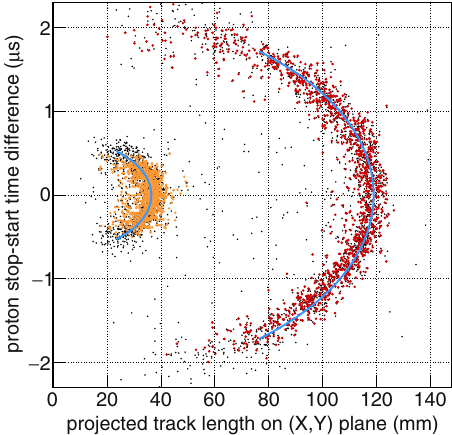
Fig. 4 Drift velocity estimate from tracks fi ts. The plot shows the distribution of the drift time difference between proton stop and start points versus the projected length of the signal on the ( X , Y ) pad plane. The colour points are events selected for the drift velocity estimate from the 1.20 MeV (orange) and the 2.50 MeV (red) protons.